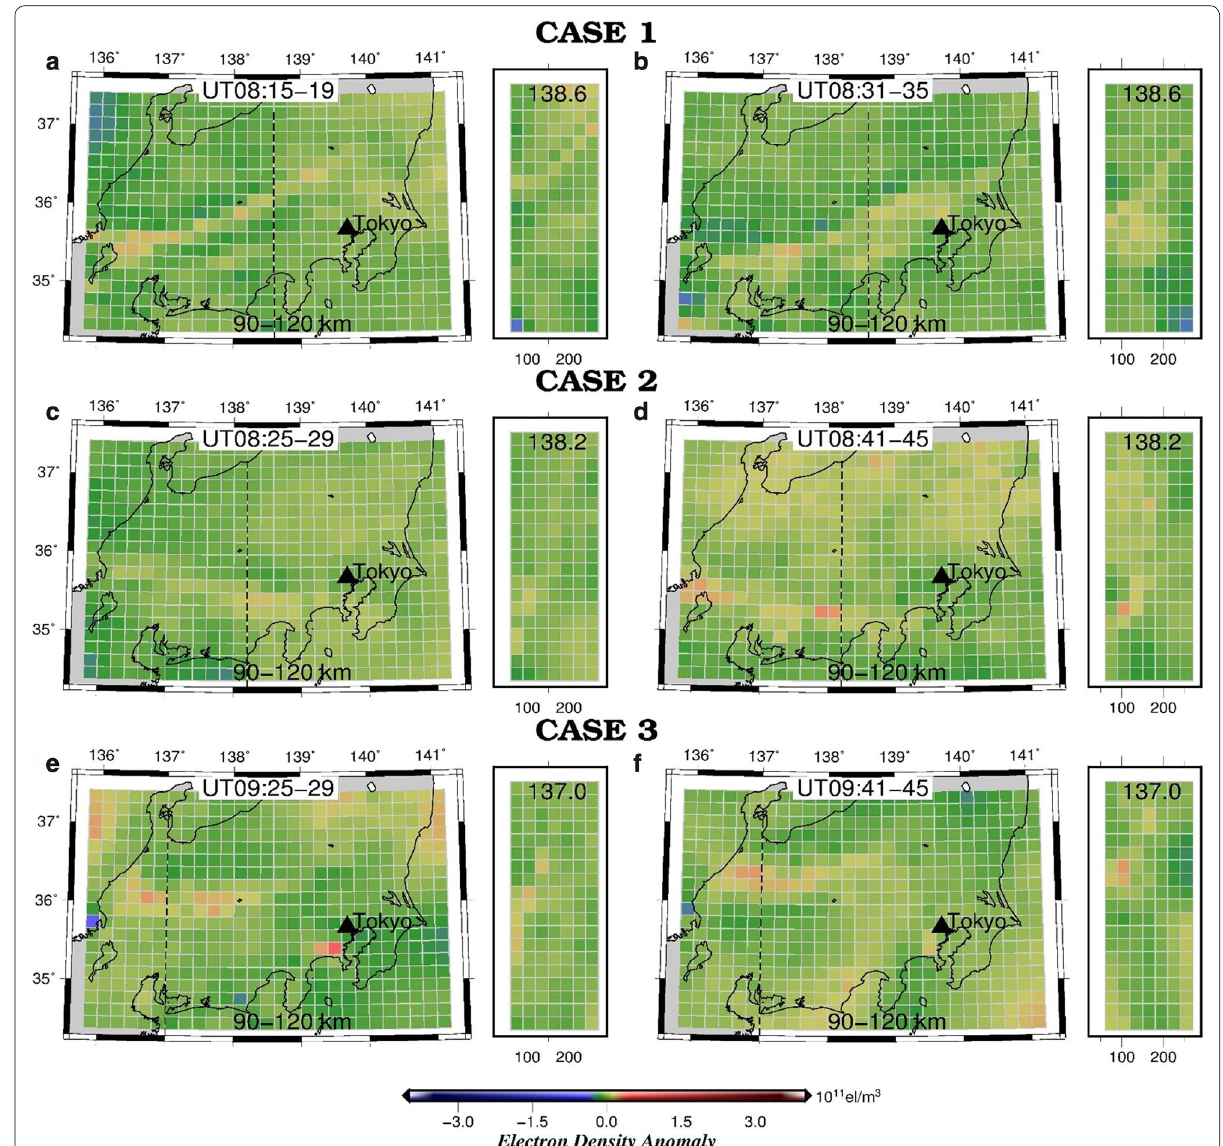
Fig. 8 Horizontal drifts of Es patches in three cases (Case 1: May 14, 2010, Case 2: May 21, 2010, and Case 3: May 13, 2012) above the Kanto District inferred by comparing the snapshots at the first epoch ( a , c , and e ) and 15 min later ( b , d , and f ). At each epoch, we show the map view (left) and the longitude-height profile (right). Black dashed lines indicate the longitudes used for the